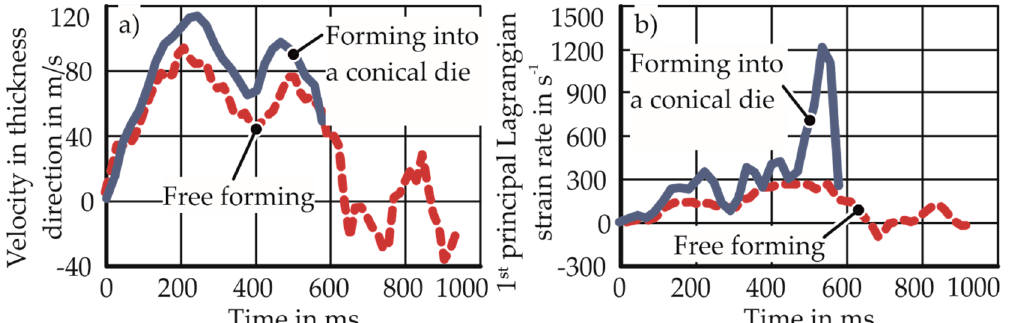
Figure 3. Electrohydraulic forming into a round die opening, with a conical die (in blue) and without a conical die (in red) (Rohatgi et al. [13]). Measurements are from the specimen apex. The conical die angle is 84°. ( a ) Increased specimen velocity due to the die; ( b ) increased strain rate due to the die.